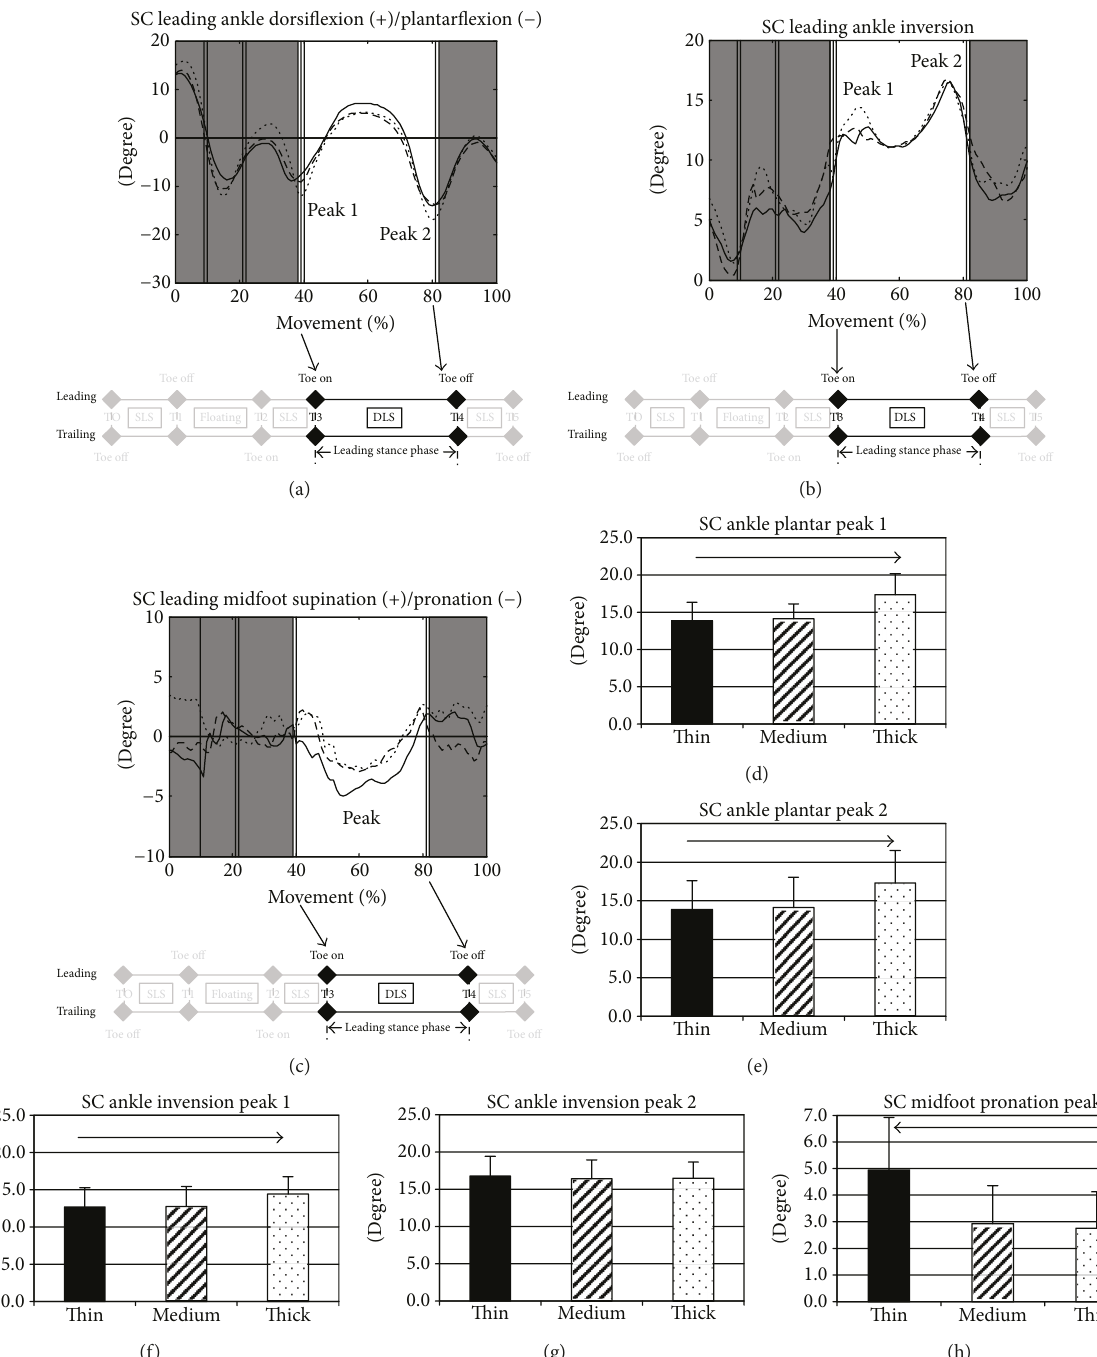
Figure 2: Angular displacement curves of the (a) ankle dorsi fl exion (+)/plantar fl exion ( − ), (b) ankle inversion, and (c) midfoot supination (+)/pronation ( − ) GRF of the leading stance limb when performing lateral side cutting for the thin (thick lines), medium (dash lines), and thick (dot lines) midsoles during the stance phase. The vertical lines indicate the instances when the leading toe is o ff (T1), the trailing toe is on (T2), the leading heel strikes (T3), and the leading heel is o ff (T4) the ground. Focusing on the leading stance phase, peak 1 indicates the peak ankle plantar fl exion and peak ankle inversion during the early leading stance phase and peak 2 indicates the peak ankle plantar fl exion and peak ankle inversion during the late leading stance phase and the “ peak ” midfoot pronation around the middle of leading stance phases. Comparisons of these peaks among midsole conditions are displayed as bar charts in (d) and (e) for ankle plantar fl exion, (f) and (g) for ankle inversion, and (h) for midfoot pronation, with corresponding standard deviations as error bars. With increasing midsole thickness, the right arrow above the graph indicates a statistically signi fi cant increasing linear trend and the left arrow indicates a statistically signi fi cant decreasing linear trend ( p < 0 05 ) (black bar: the thin midsole, dashed bar: the medium midsole, and dotted bar: the thick